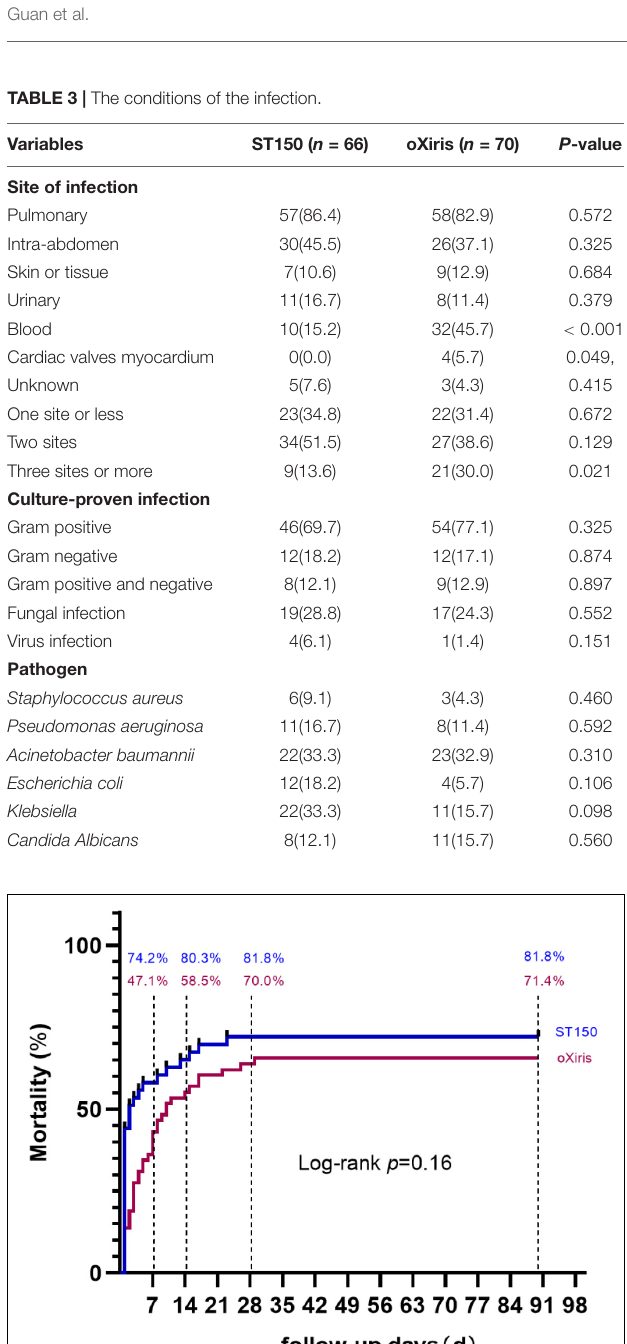
FIGURE 2 | The Kaplan–Meier estimates of mortality at 90 days. In the modified intention-to-treat analysis, death at 90 days occurred in 50 patients (71.4%) in the group that received oXiris and in 54 (81.8%) in the group that received ST150. P = 0.16 for the between-group difference in the Kaplan–Meier time-to-event